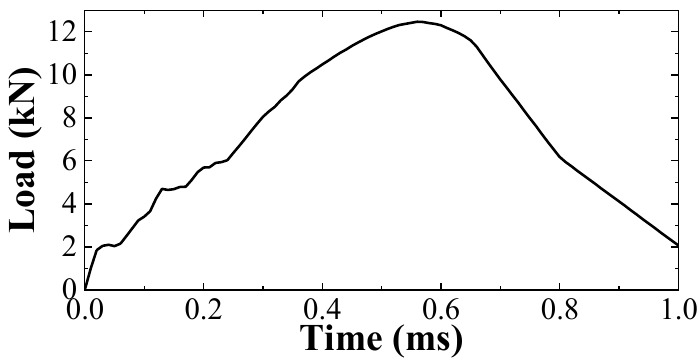
Figure 2. Impact test of a concrete beam. ( a ) Geometry (Unit: mm); ( b ) FE model.